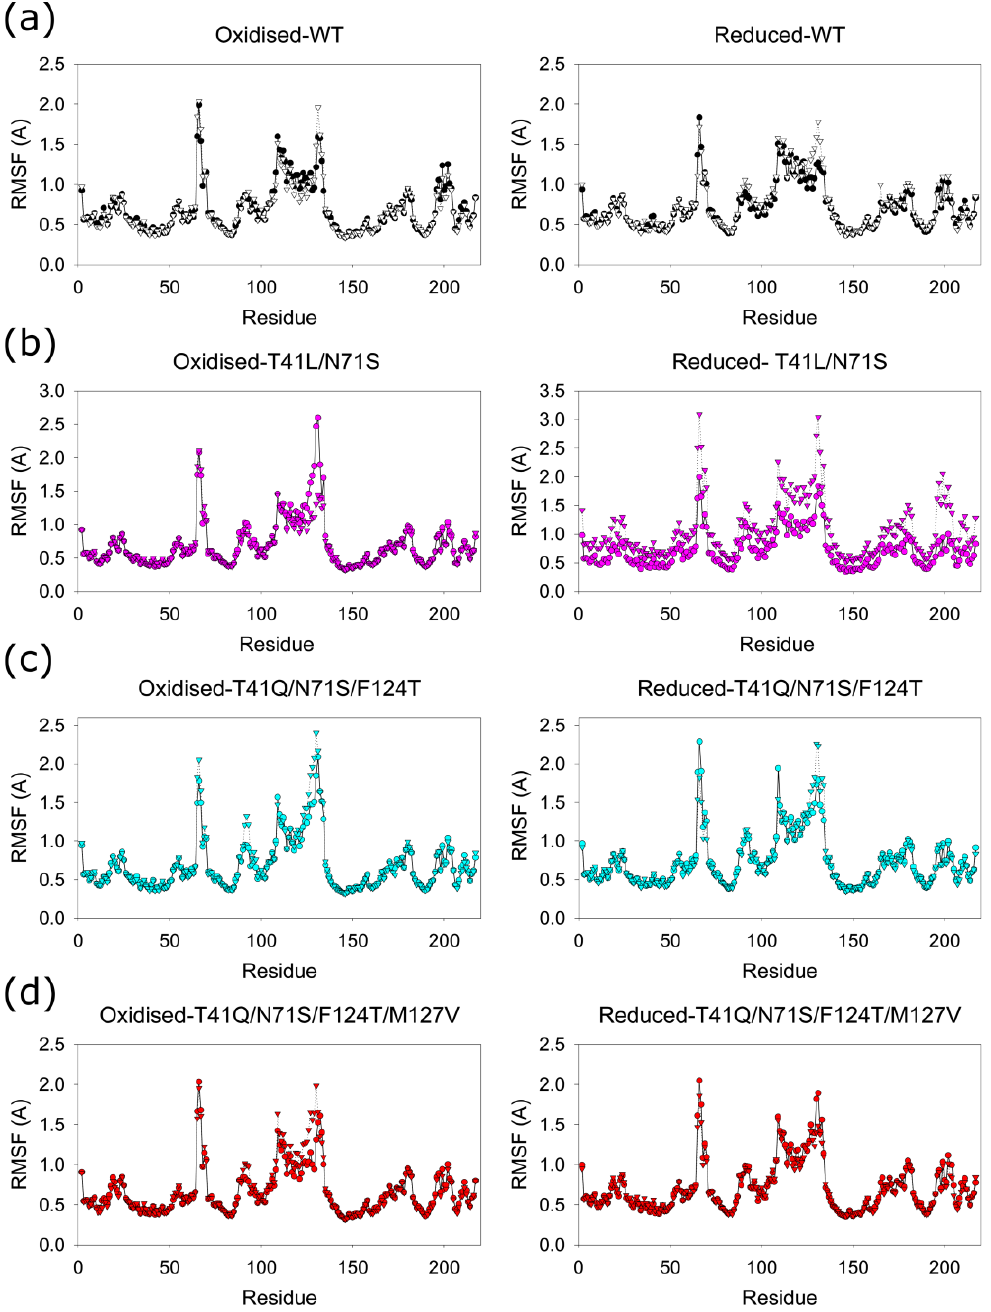
Figure 8. Root-mean-square fluctuations of C α atoms in wild-type and mutant proteins. Each symbol is the average of the RMSFs in three runs. Circles are for subunit 1, and triangles are for subunit two. Left shows the enzymes with oxidized cofactor (FMN) in the active sites, and right is for enzymes with reduced cofactor (FMNH − ) in the active sites. ( a ) Black and white symbols, wild-type enzyme, ( b ) magenta symbols, T41L/N71S enzyme, ( c ) cyan symbols, T41Q/N71S/F124T enzyme, and ( d ) red symbols, T41Q/N71S/F124T/M127V.